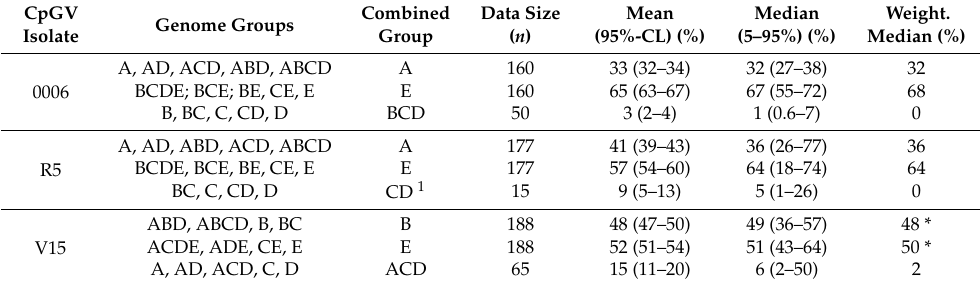
Table 2. Genome group compositions of CpGV-0006, CpGV-R5, and CpGV-V15 mean and median frequencies of SNP variants with correspondent 95% confidence limits and five to 95 percentiles, respectively. Weighted medians are calculated by weighting the medians with the number of individual points from a dataset (data size = n ). Post-hoc Tukey’s Honestly Significant Differences test (Tukey-HSD) was performed to evaluate significant differences in medians ( p =